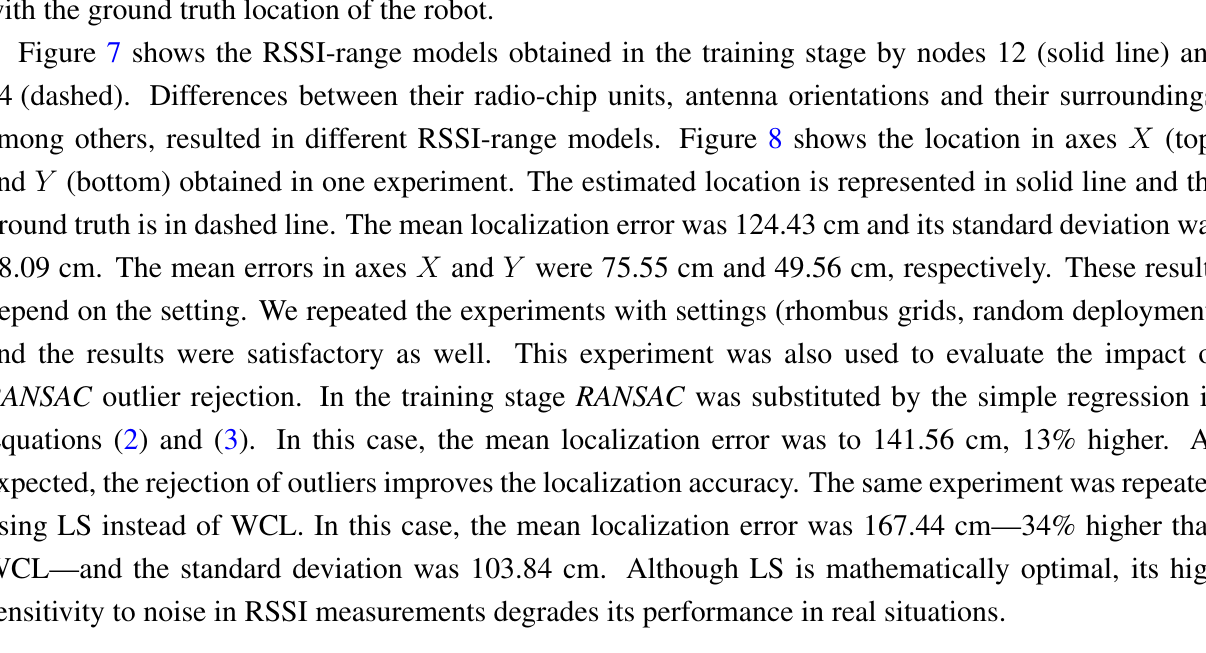
Figure 7. RSSI-range model for two nodes of the CONET testbed.